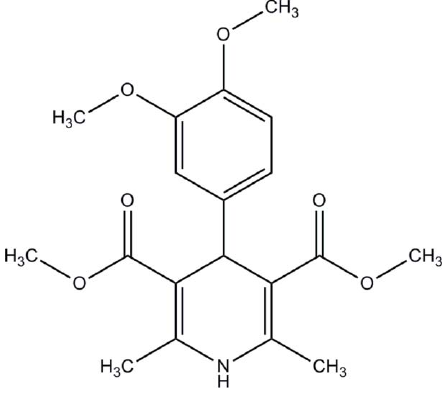
Experimental Crystal data